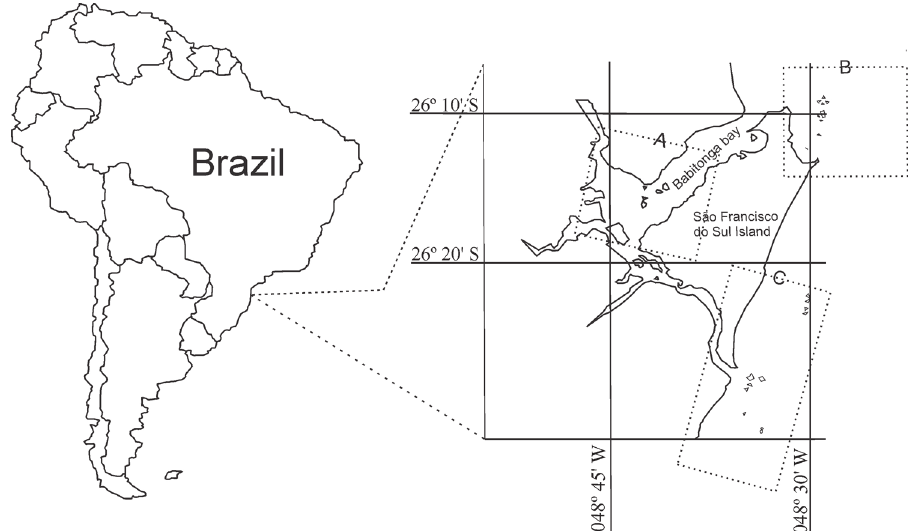
Fig. 1. São Francisco do Sul Island and Babitonga bay, Southern Brazil. Detached areas (a, b and c) are those detailed in Fig.